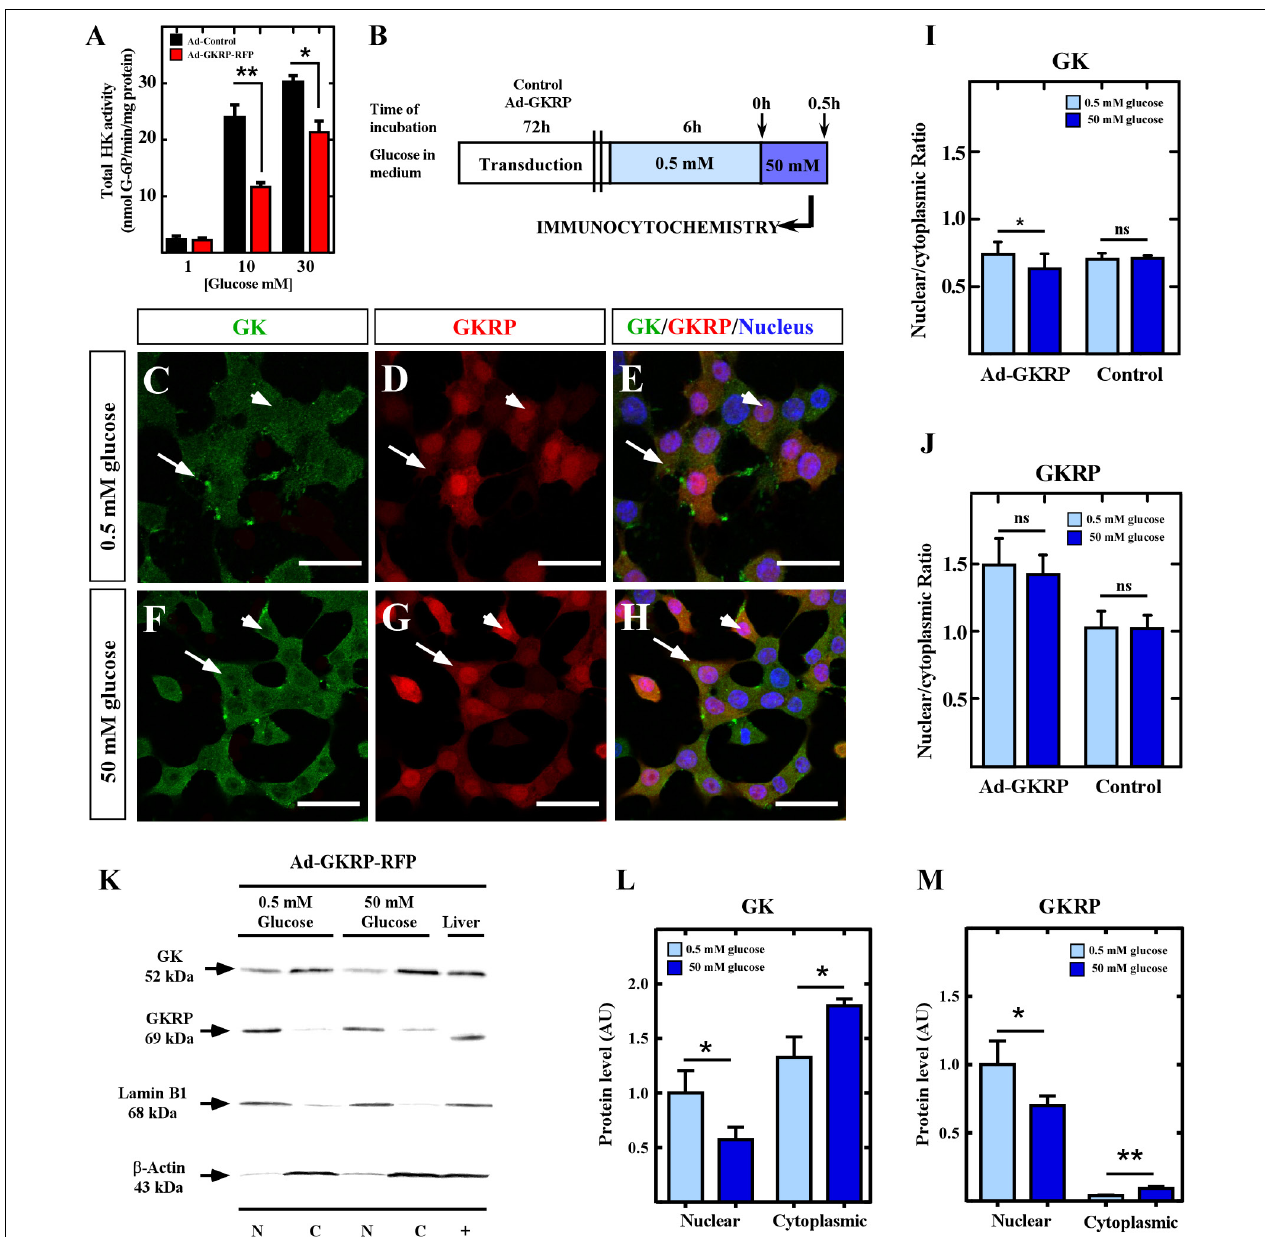
FIGURE 2 | Subcellular localization of GK and GKRP in insulinoma cells overexpressing GKRP. (A) Total hexokinase activity measured at 1, 10, and 30 mM glucose on Ad-GKRP (red bars) and Ad-Control (black bars). (B) Schema of glucose treatments for transduced cells to evaluate compartmentalization dynamics. (C,D) Immunocytochemistry for GK (C,F) and GKRP (D,G) of cells cultured at 0.5 mM (C–E) and 50 mM (F–H) glucose. (I,J) Quantification of nuclear and cytoplasmic fluorescence for GK (I) and GKRP (J) immunocytochemistry. (K) Immunodetection by western blot of GK (52 kDa, first panel) and GKRP (69 kDa, second panel) in nuclear and cytoplasmic protein extracts of transduced insulinoma cultured at 0.5 and 50 mM glucose. Lamin B1 (68 kDa, third panel) and β -actin (43 kDa, fourth panel) were used to confirm the purity of extracts and correct nuclear and cytoplasmic quantification. (L,M) Densitometry analysis of GK (L) and GKRP (M) at